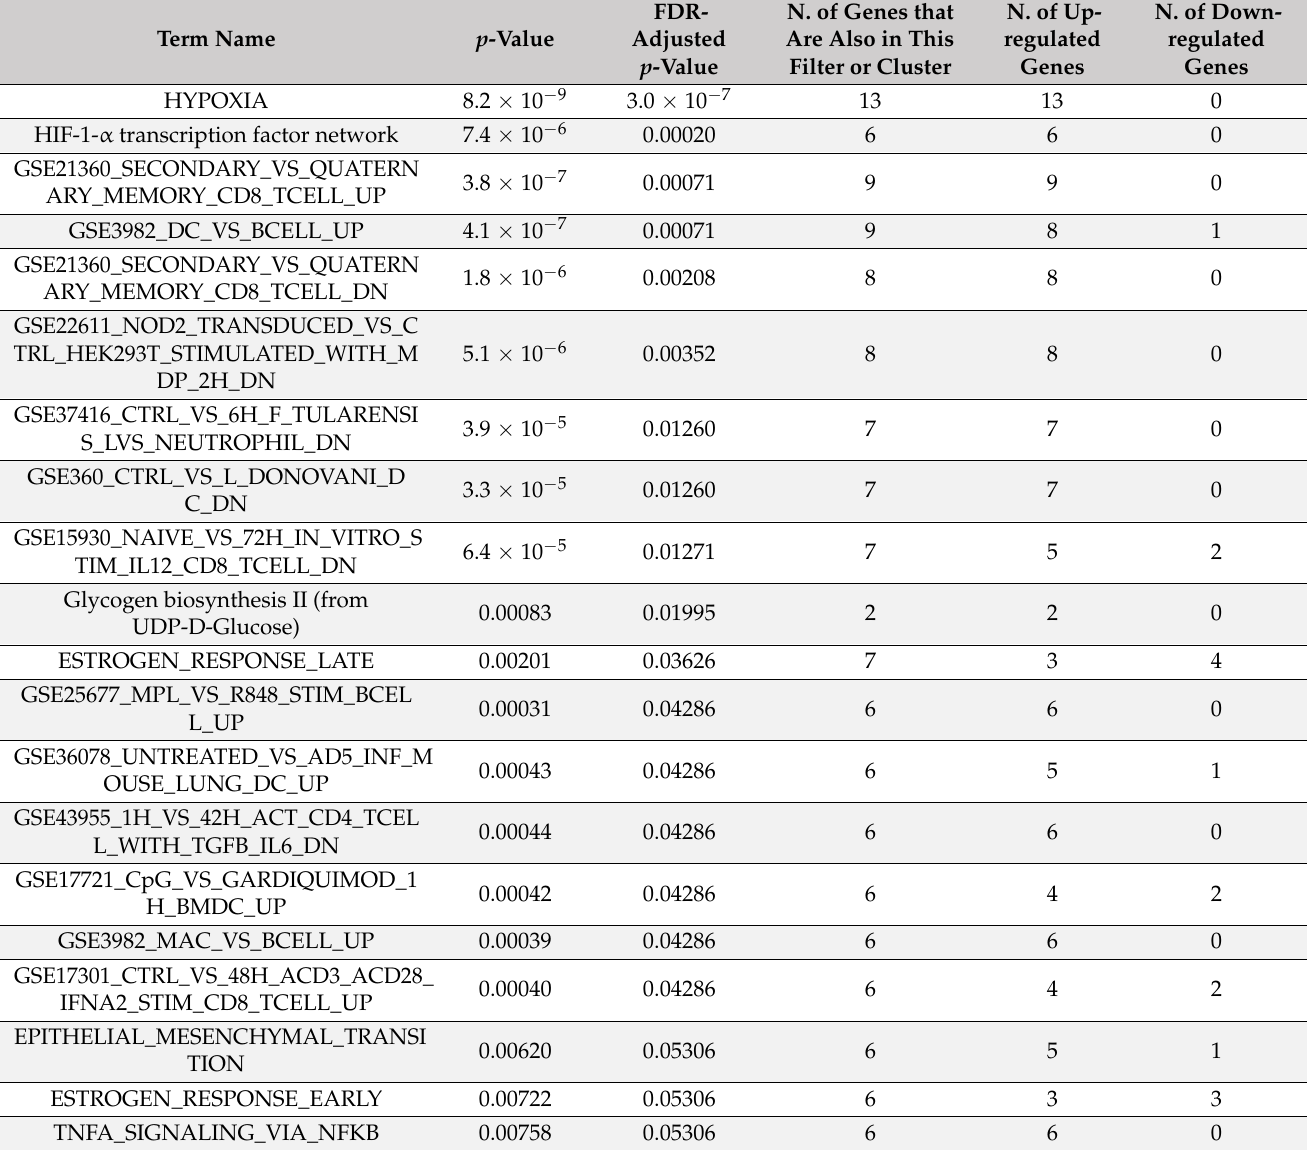
Table 2. Enriched significant pathways (FDR-adjusted p -Value ≤ 0.05). FOOTNOTE: N.: